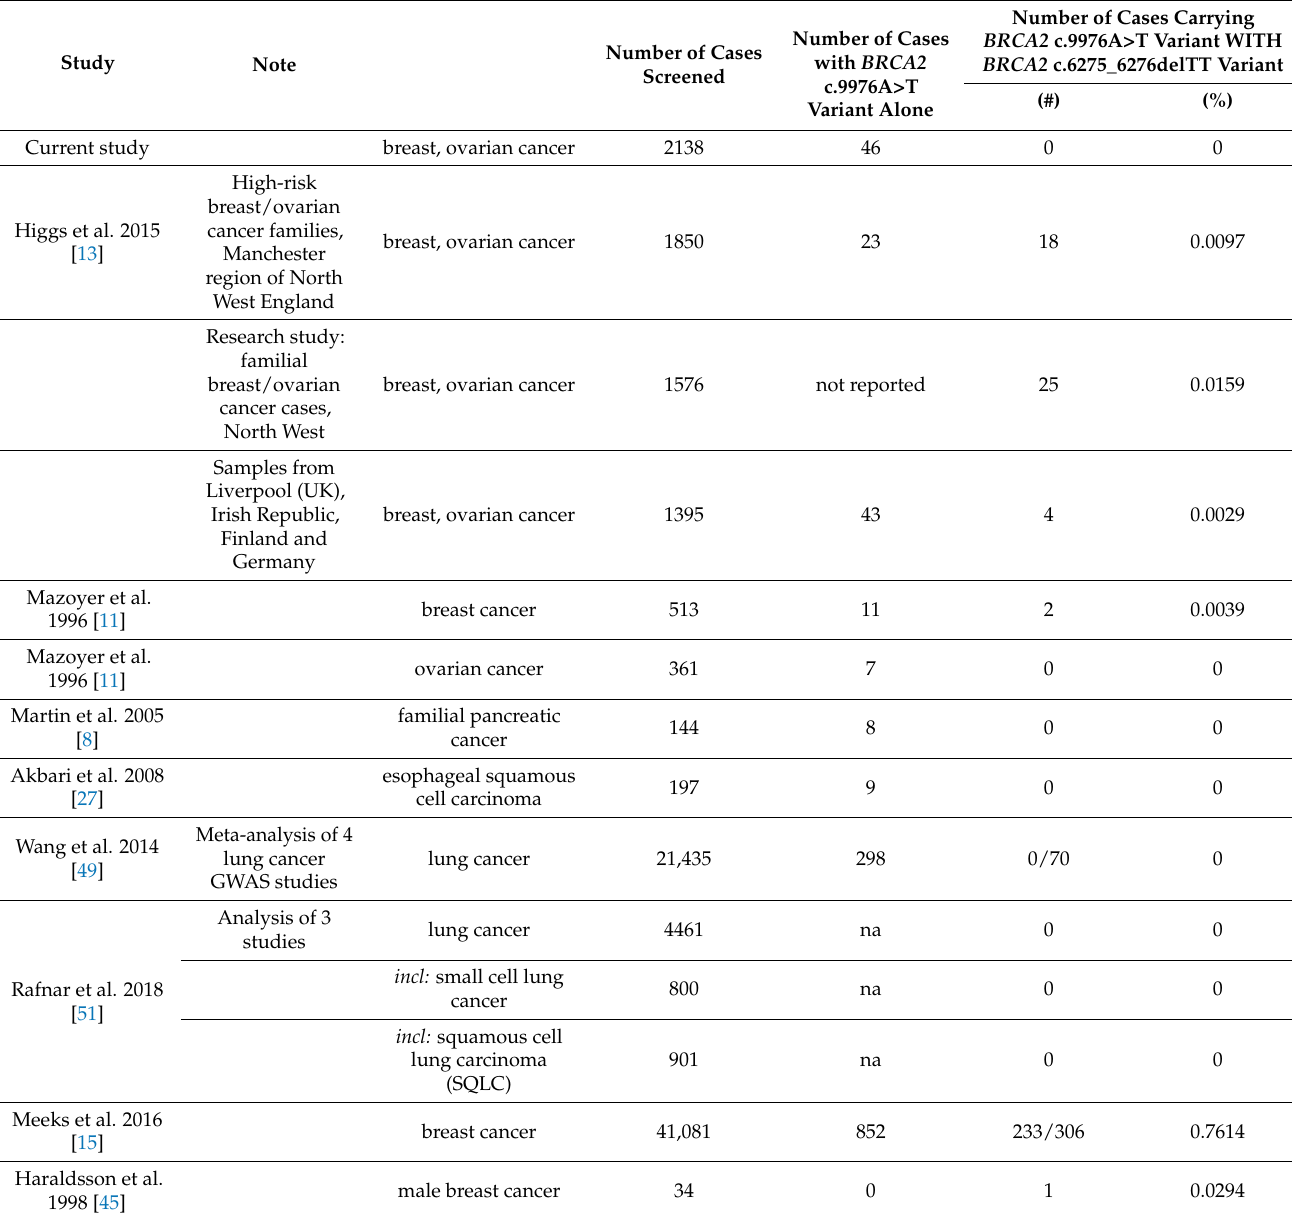
Table 5. Studies analyzing linkage of c.9976A>T and